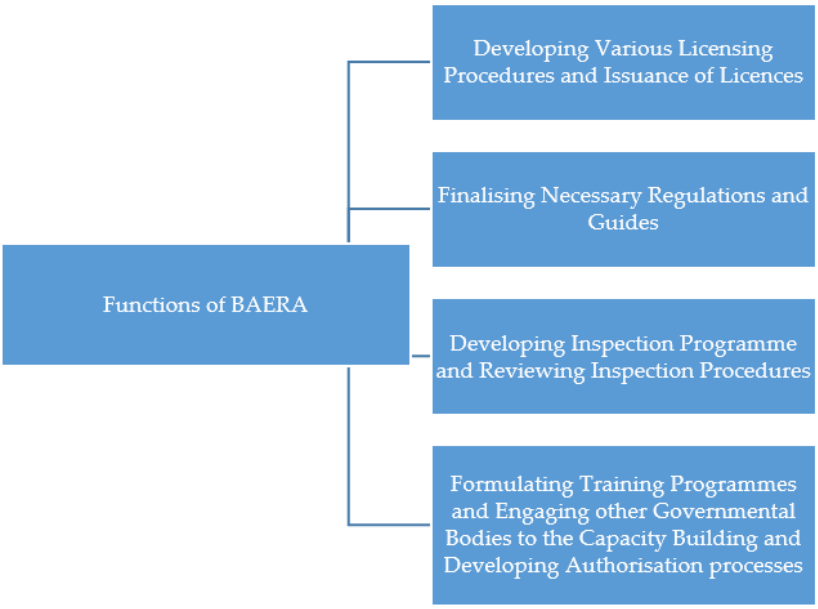
Figure 6. Functions of Bangladesh Atomic Energy Regulatory Authority.